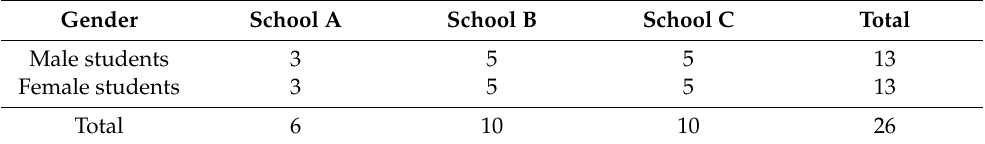
Table 4. Gender distribution by